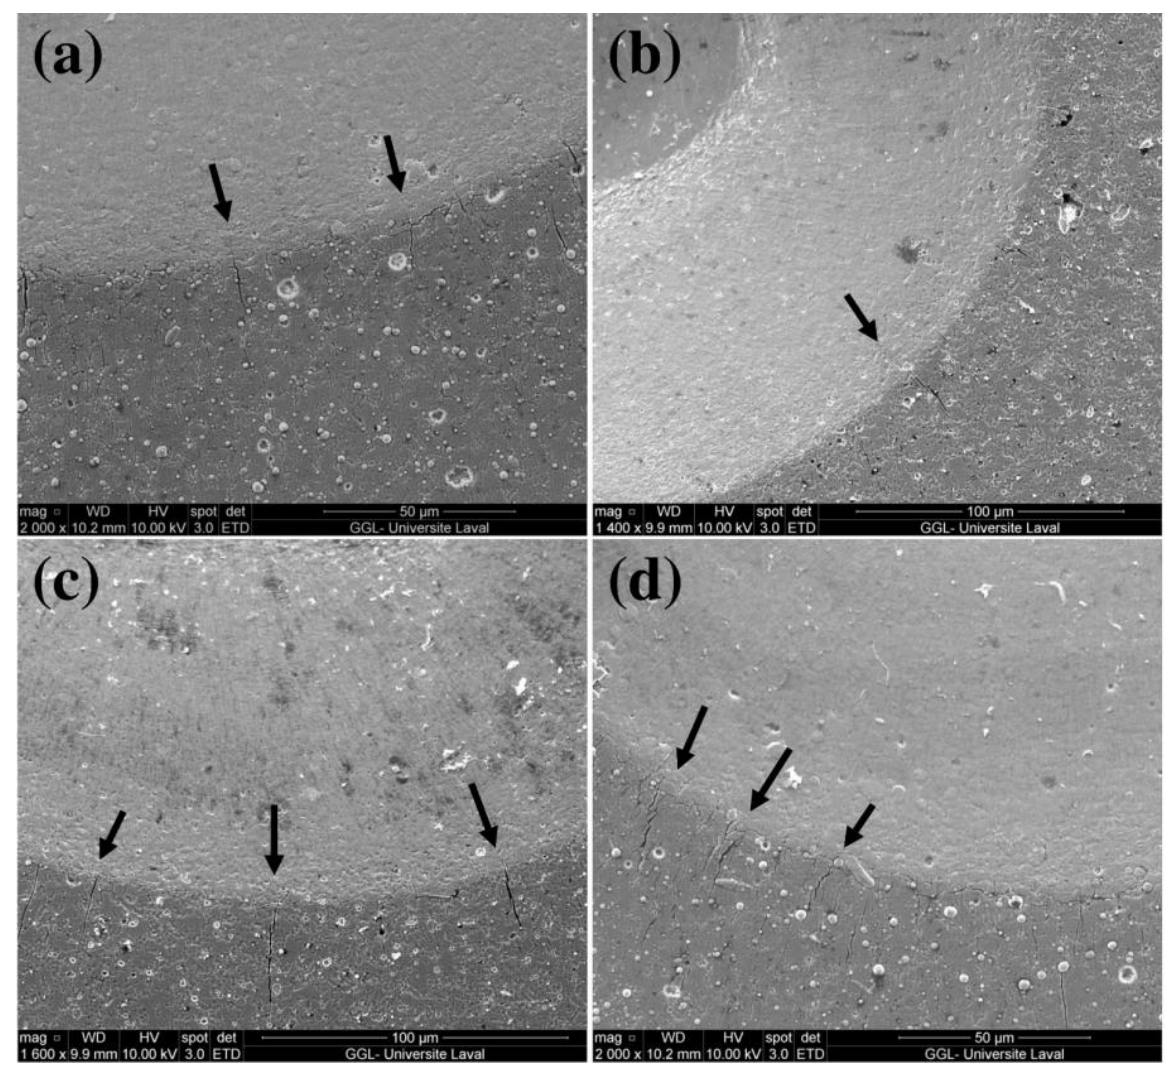
Figure 10. SEM micrographs of the micro cracks on coated carbide substrates after Daimler–Benz adhesion tests ( a ) CrN/CrCN/DLC, ( b ) CrN/AlTiN, ( c ) CrN/CrCN, and ( d ) CrCN/TiSiCN.